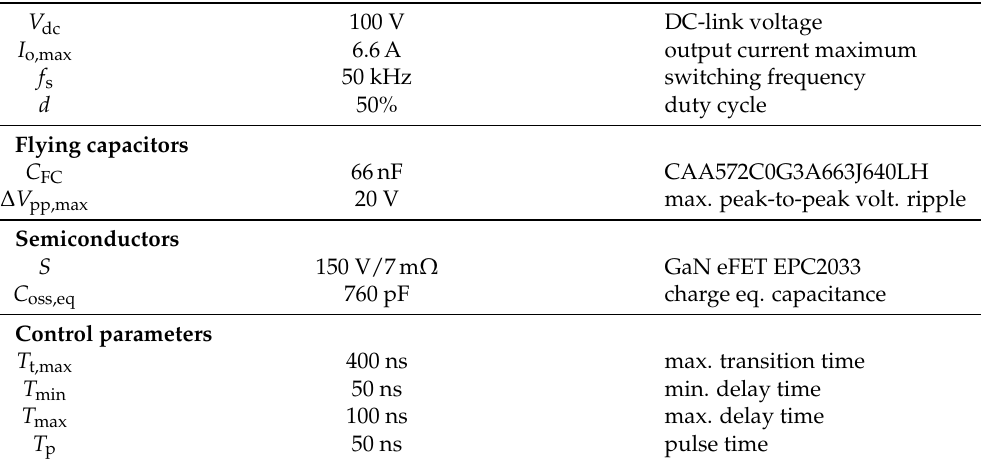
Figure 10. Photos of the realized 5L-FCC HB demonstrator: ( a ) General assembly, ( b ) power board and detail view of the switching cell PCBs. Table 3. Specifications and control parameters of the Q2L-5L-FCC proof-of-concept